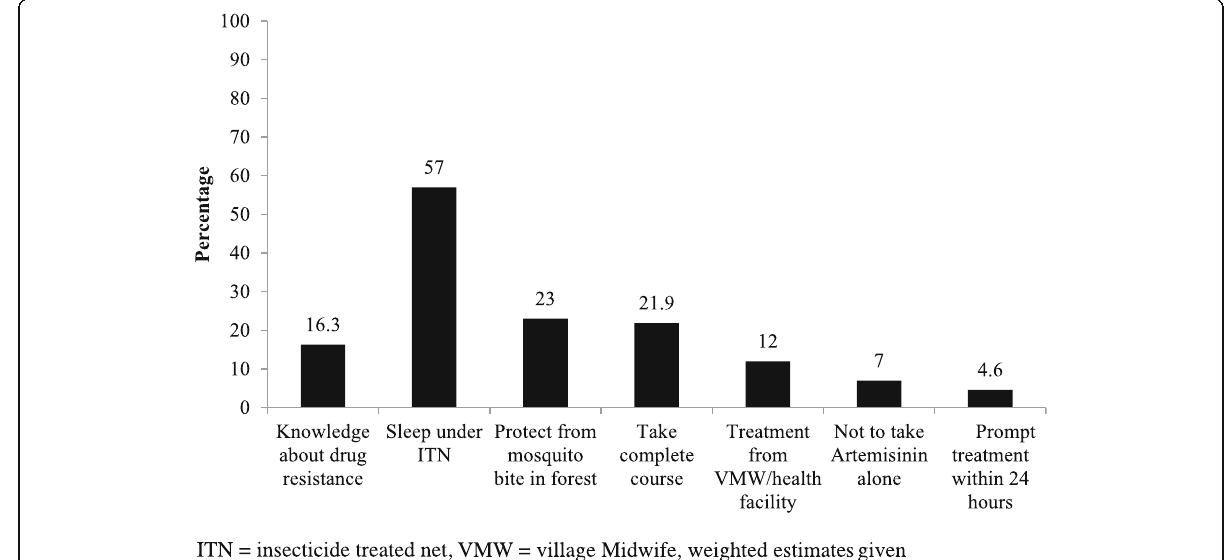
Fig. 4 Awareness about anti-malarial drug resistance and its prevention among the general population in the endemic regions of Myanmar in